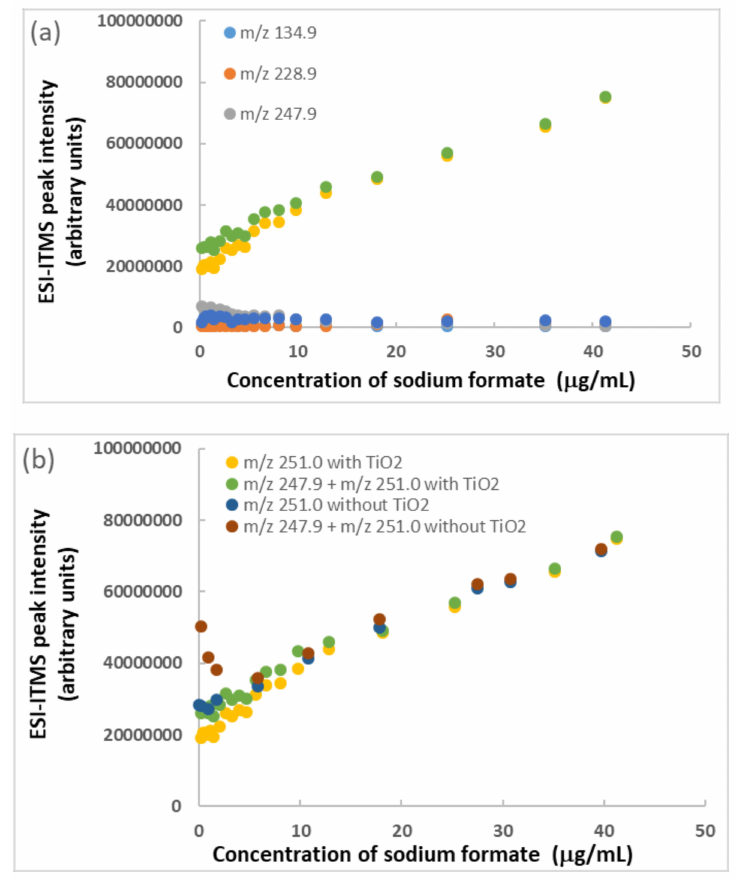
Figure 4. E ff ect of sodium formate concentration on minimization of m / z 247.9 peak intensity and maximization of m / z 251.0 peak intensity in ESI-ITMS analysis: ( a ) BPA standard solution (1.8 µ g / mL) containing TiO 2 nanoparticles (176 µ g / mL) and ( b ) BPA standard solution (1.8 µ g / mL) only for comparison. Relative standard deviation of each data point =